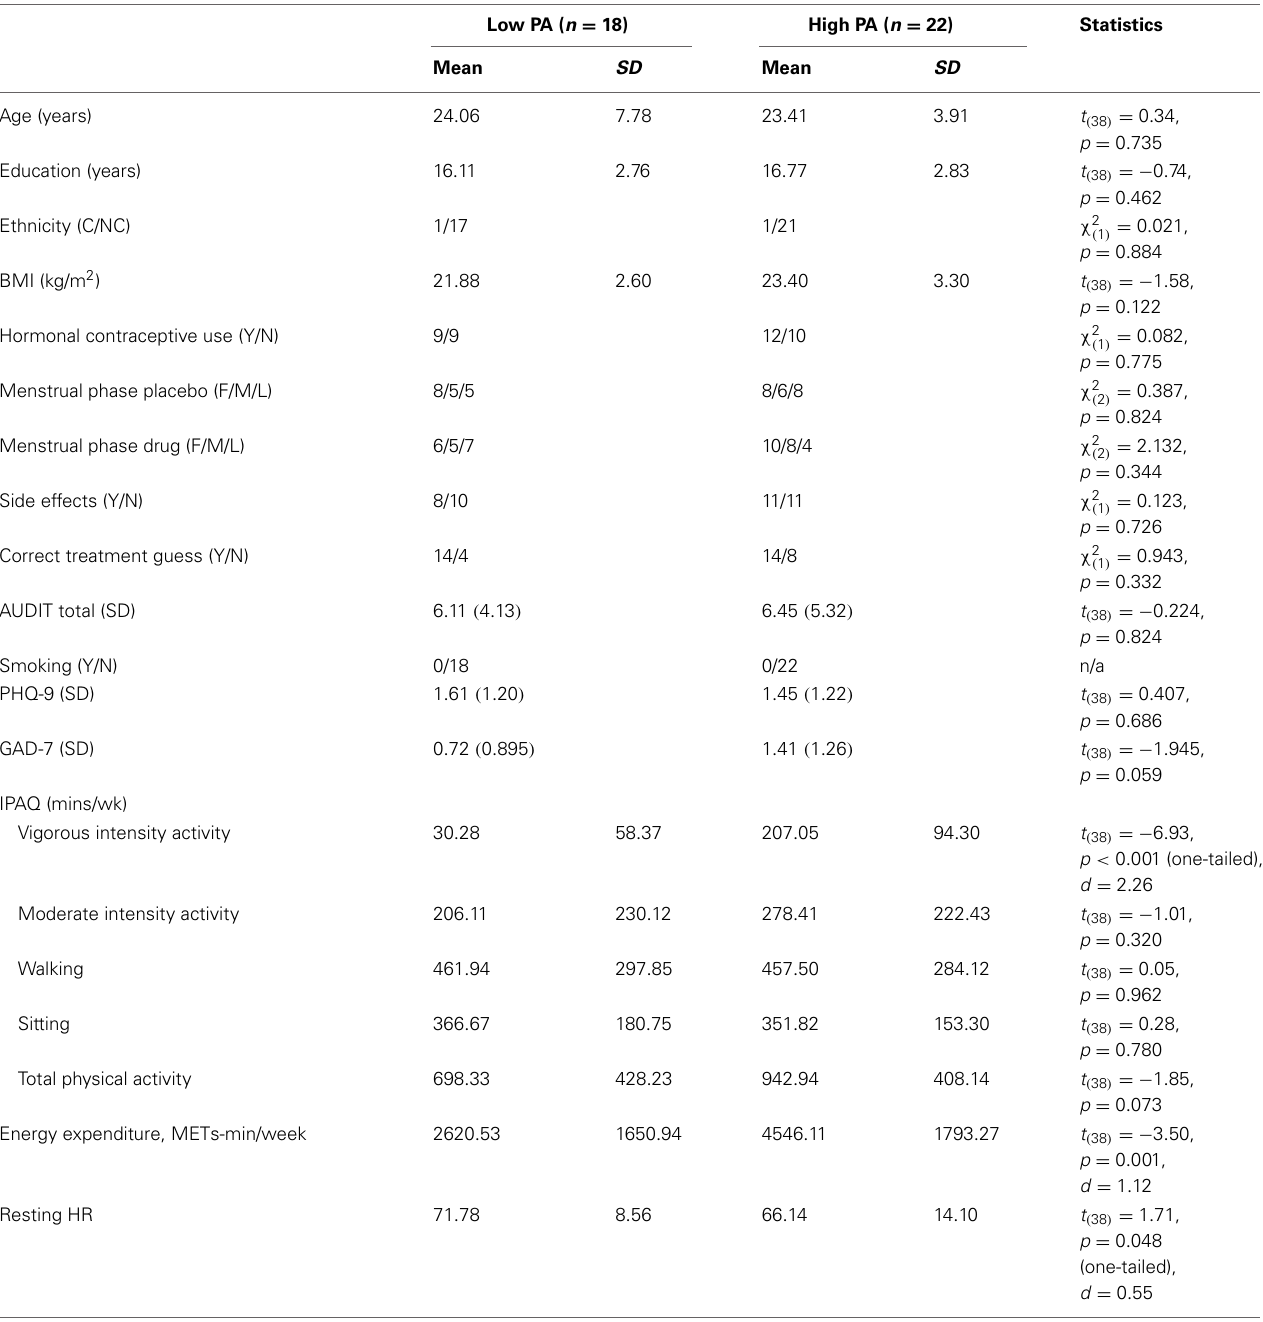
Table 1 | Participant demographic